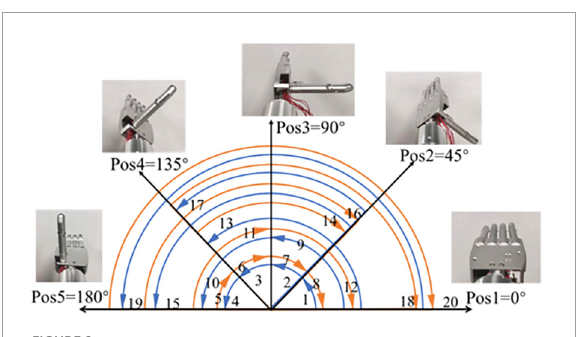
FIGURE2 The five target positions and 20 movements of the experiment.